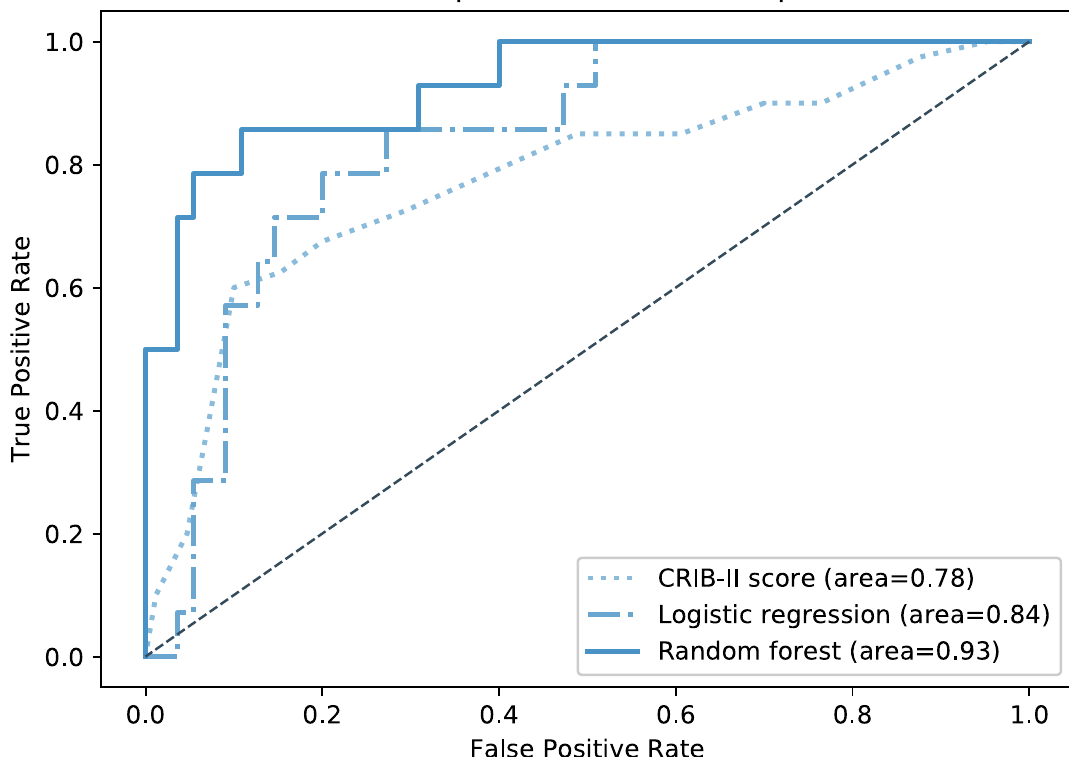
Figure 1. ROC curves for per-infant model comparison. Comparison of receiver operating characteristic (ROC) curves for the CRIB-II score, logistic regression model, and per-infant random forest model. Each of these three approaches makes a single prediction (“worry” or “don’t worry”) per infant, where “worry” indicates impending